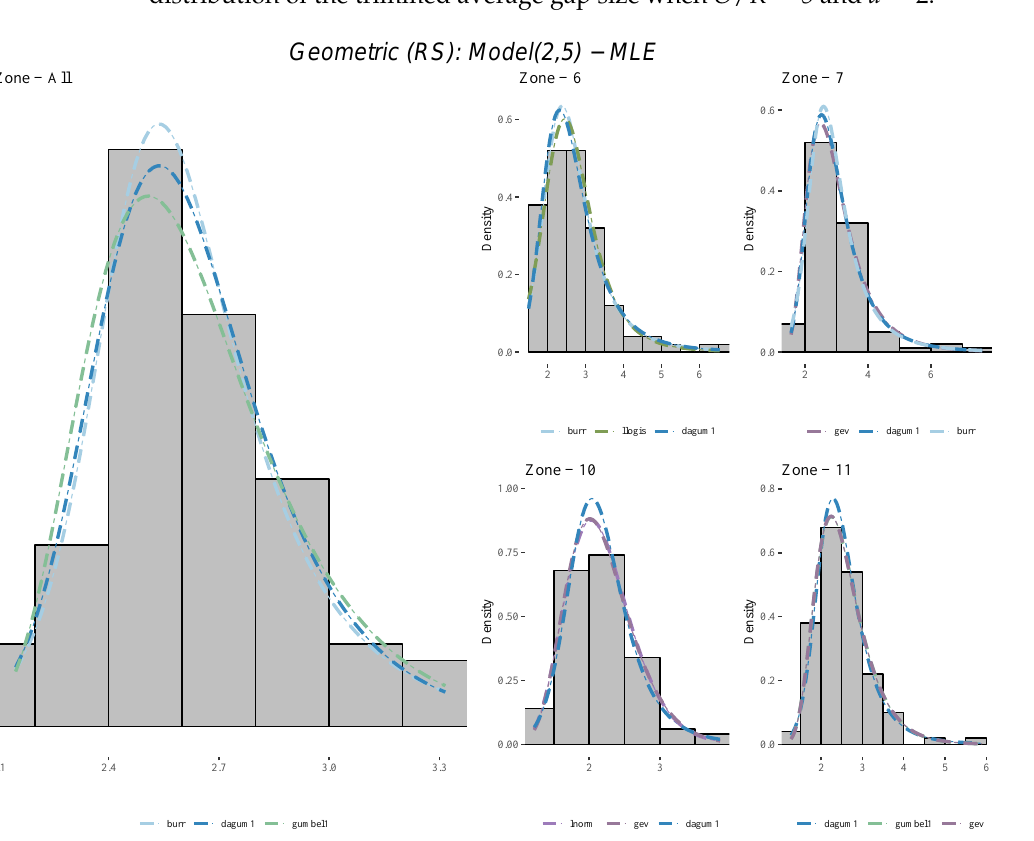
Figure 8. Histogram representation of the trimmed mean gap size for each of the four central zones and the entire assembly along with the top three corresponding fitted